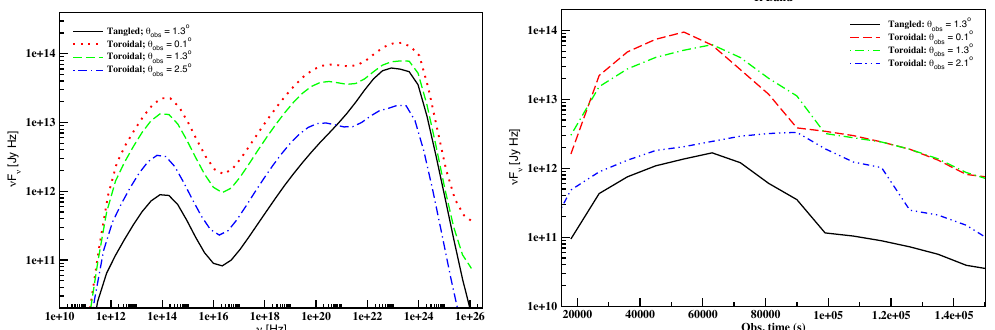
Figure 5. ( Left ): Comparison of time-averaged SEDs of the generic blazar obtained using a toroidal magnetic field with that generated using a tangled field. Within the toroidal geometry, the three SEDs are obtained by varying the viewing angle; ( Right ): Pulse profile of an optical synchrotron photon in the R band, for the same cases, for various viewing angles.